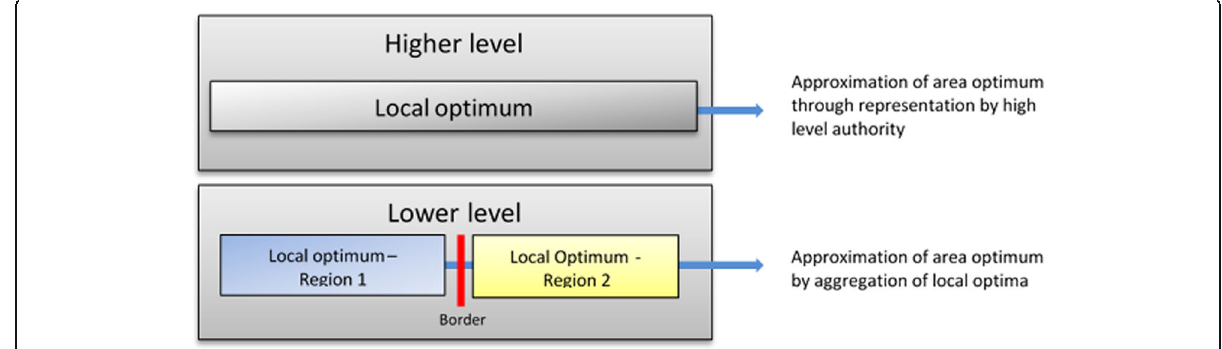
Fig. 4 Identifying area optima in multi-level governance situations. Figure by author